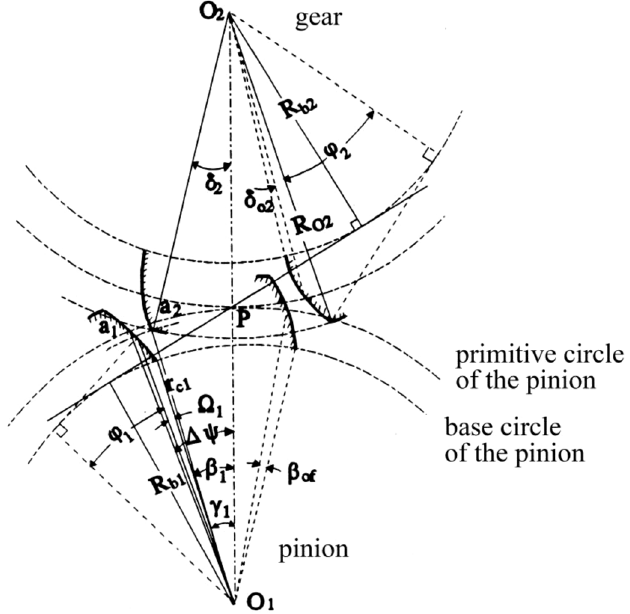
Fig. A.2. Radius r c1 resulting from premature contact of a pinion tooth with the tip of a gear tooth.